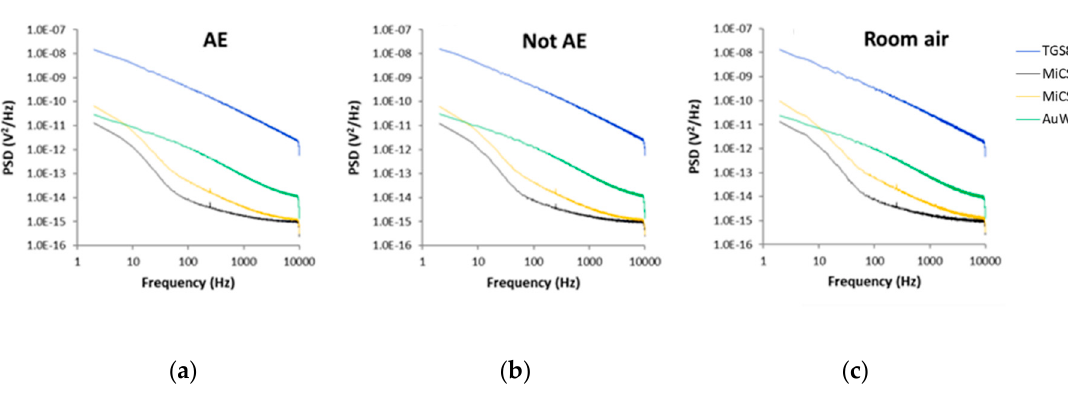
Figure 5. Power spectral densities of voltage fluctuations measured across the sensors exposed to a breath sample, as well as before sample measurement and after cleaning the test chamber with synthetic air. ( a ) AuWO 3 sensor; ( b ) MiCS 6814#NH 3 sensor.